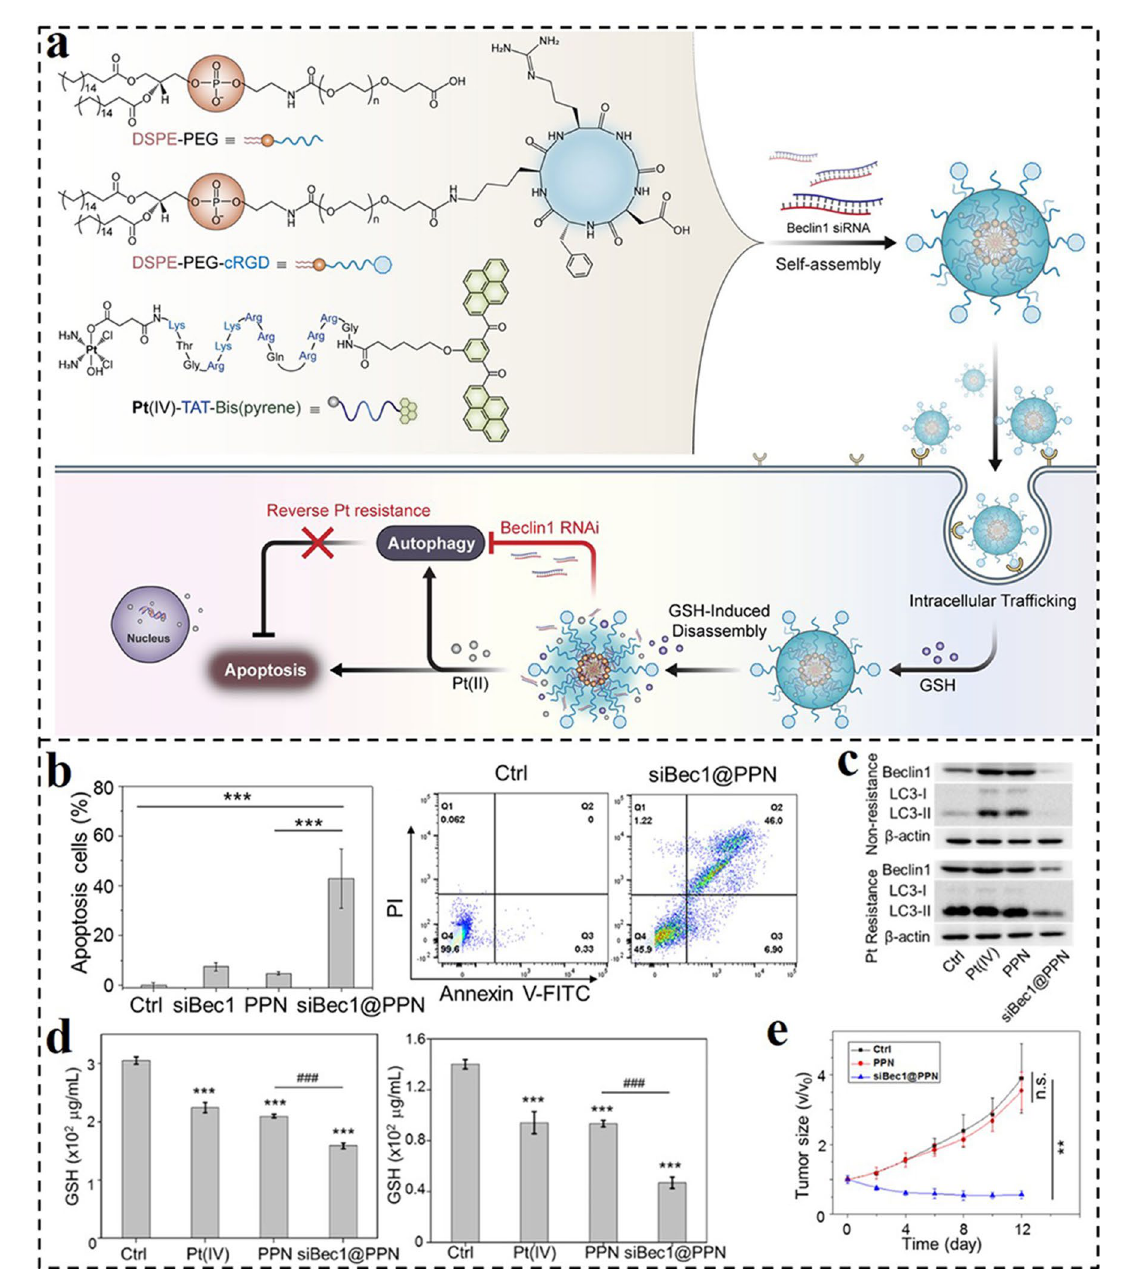
Fig. 7 a Illustration of the self-assembled nano-prodrug system for co-delivery of gene and cisplatin, and the mechanism of cisplatin resistance reversion through RNAi-mediated autophagy inhibition. b Annexin V-FITC/PI assay for apoptosis detection in A549 tumor treated with different formulas. c Western blot of Beclin1 and LC3-II in A549 cells or Pt-resistant A549 cells treated with different formulas. d GSH level of Pt-resist- ant A549 cells and normal A549 cells treated with different formulas. e Tumor volumes of Pt-resistant A549 tumor-bearing athymic nude